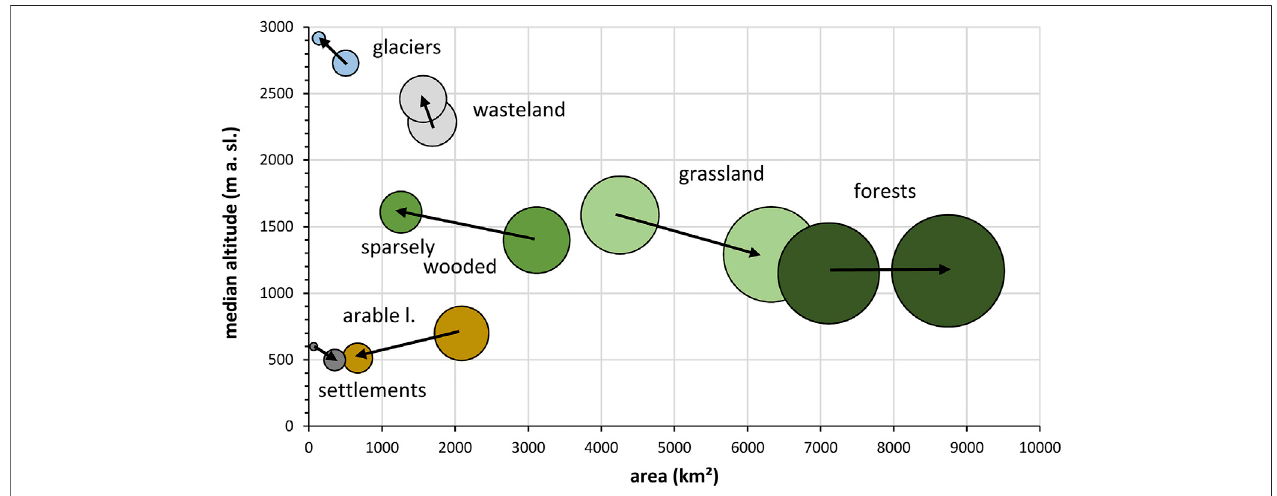
FIGURE 8 | Altitudinal shifts (Y-axis) and changes in areal extents (X-axis) of selected types of land cover/use between 1826 – 1859 and 2016. Altitudes refer to median values; sphere size re fl ects relative changes in areal extents (arrows: development from 1826 – 1859 to 2016).